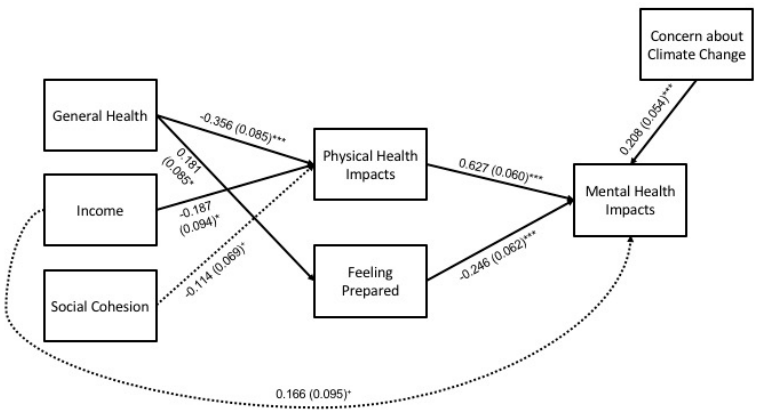
Figure 4. Path model for mental health impacts during winter extremes (N = 397). Statistically significant pathways are shown with standardized estimates and standard errors (SEs) in parentheses. Statistical significance levels are: + p < 0.10, * p < 0.05, and *** p < 0.001. Table 7. Path analysis results for winter extremes, overall ( N = 397).